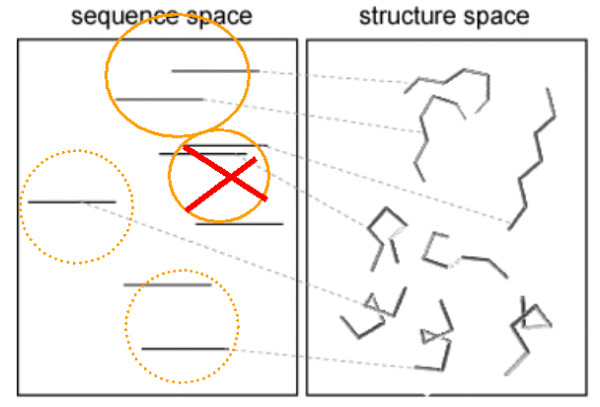
Clustering in sequence space and discarding clusters with too much structural variation (Baker's Method).